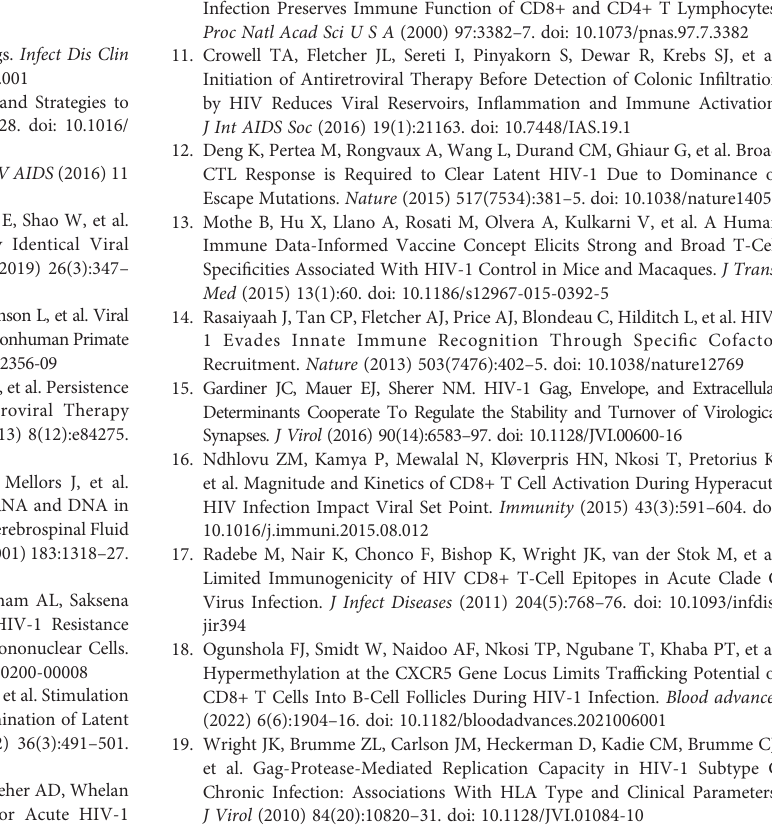
recombinant viruses at a scale of 0.008. “ PL ” indicates pre-therapy plasma, “ PB ” indicates peripheral blood mononuclear cells and “ LN ” indicates lymph node mononuclear cells. The suf fi x “ PCR ” indicates the sequences of amplicons from the different body compartments, while “ Virus ” indicates the sequences from the matched cultured recombinant viruses. Highlighted in green are the HIV 1 subtype C consensus and NL4-3 laboratory strain virus sequences. Supplementary Figure 2 | Representative fl ow cytometry plots measuring replication capacities of viruses in the presence and absence of interferon alpha. The replication capacities of the recombinant viruses encoding gag-protease from the lymph node (LN) and peripheral blood mononuclear cell (PBMC) reservoirs, as well as from the pre-therapy plasma, in the presence and absence of type I interferon alpha (IFN- a ) was measured. Replication capacity was measured as the spread of infection from days 3 to 6 post-infection, where infected cells (expressing green fl uorescent protein [GFP]) were detected by measurement of GFP by fl ow cytometry. Replication capacity was calculated as the natural log of the slope of exponential increase in GFP positive cells. IFN- a resistance was calculated as the ratio of the replication capacity in the presence and absence of IFN- a . Representative data from participant 111-33-0067-0 (PID 0067) is shown. Supplementary Figure 3 | Flow cytometry gating strategies in the HIV cell-to-cell spread assay. (A) Gating of Jurkat cells based on forward scatter (FSC) and side scatter (SSC) plots is shown. Zombie NIR was used to distinguish live cells from dead cells. Plots show (i) uninfected Jurkat cells and (ii) Jurkat cells infected with 100ng p24 equivalent of virus derived from the plasma of participant 111-30-0098- 0 (0098PL), after 4-5 days of incubation. (B) CellTrace ™ far red-stained Jurkat cells (target cells - APC) and eFlour 450-stained Jurkat cells (donor cells – BV 450) are shown. (C) Plots show the spread of infection in both donor and target cells from 0- 48 hours following co-culture of donor (5% infected) and uninfected target cells at a ratio of 1:1. Infected cells were detected by intracellular Gag p24 staining